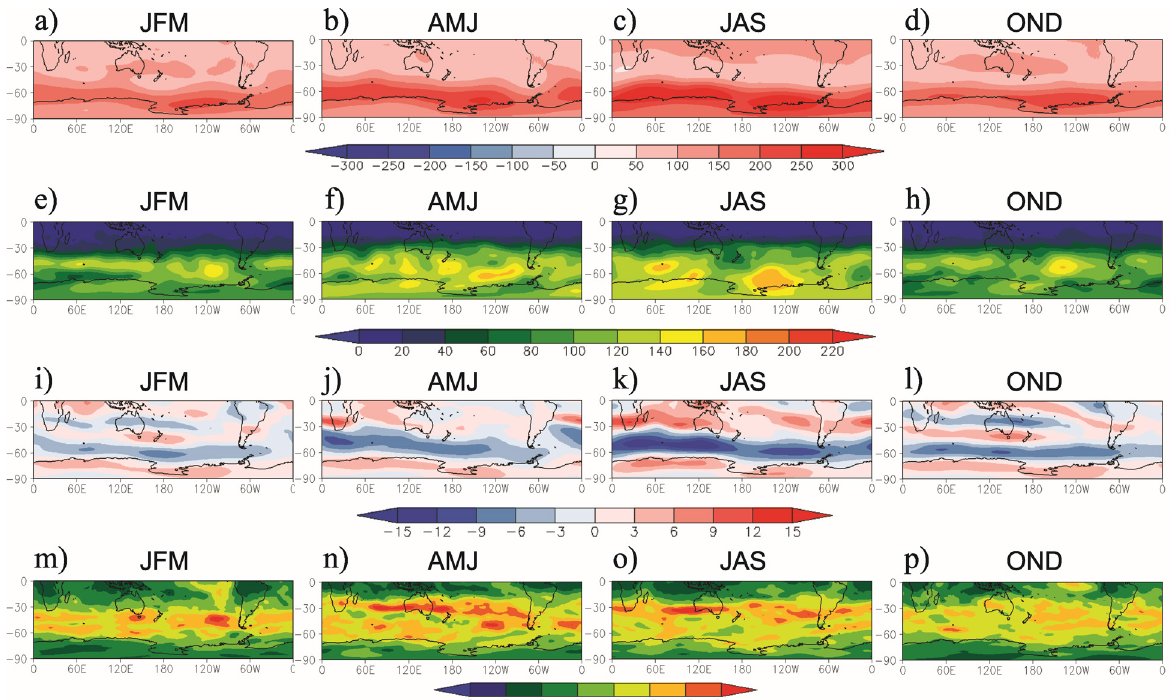
Figure 3. Seasonal difference of (a, b, c, d) 500-hPa geopotential height (m) and (i, j, k, l) 250-hPa zonal wind (ms -1 ) between the MIROC5 historical experiment and the ERA-Interim reanalysis and standard deviation of (e, f, g, h) 500-hPa geopotential height (m) and (m, n, o, p) 250-hPa zonal wind (ms -1 ) from the MIROC5 historical experiment during summer (JFM; first column), autumn (AMJ; second column), winter (JAS; third column) and spring (OND; fourth column) over